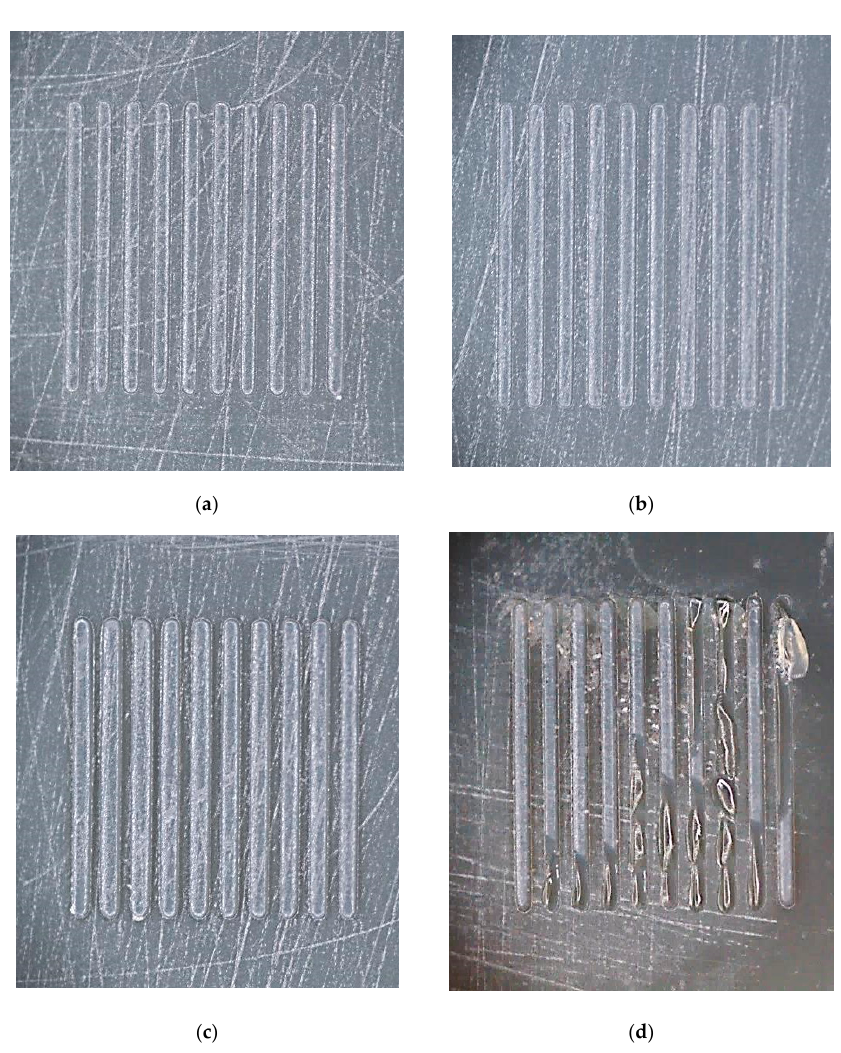
Figure 9. Optical micrographs of intact microfeatures in ( a ) Group A, ( b ) Group B, and ( c ) Group C on Tool 4 after 60 shots, and ( d ) fractured Group D microfeatures on Tool 5 after 78 shots.